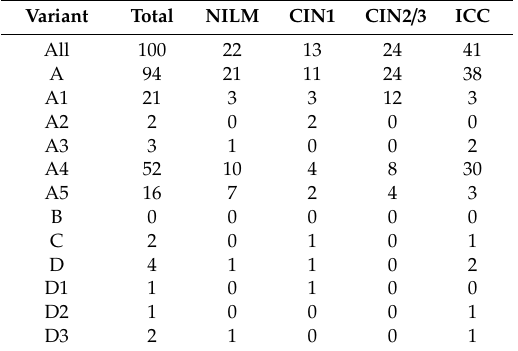
Table 1. Distribution of HPV16 variants according to cervical disease status ( n = 100).